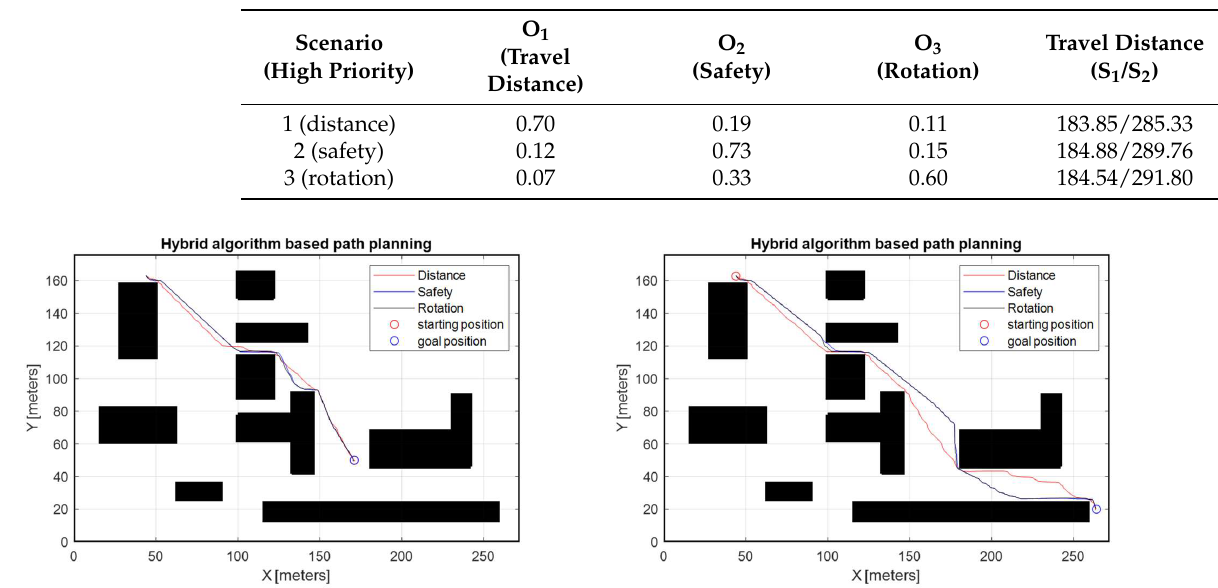
Table 3. Weighting for each objective for Hybrid path planning and results.